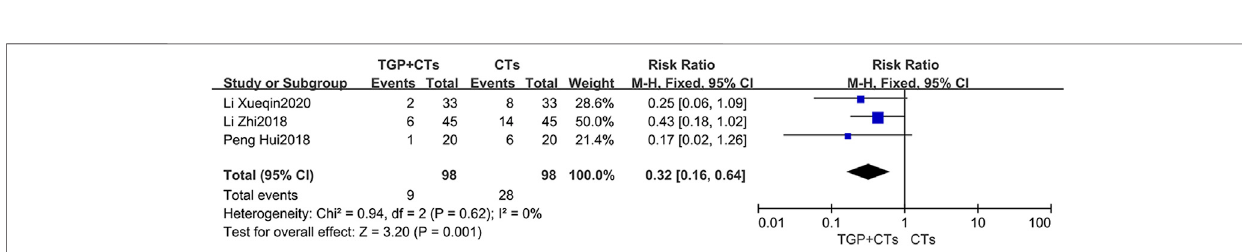
FIGURE 9 | Forest plot of cumulative cyclophosamide dosage at 1 month, 2 months (A) and 6 months (B) .